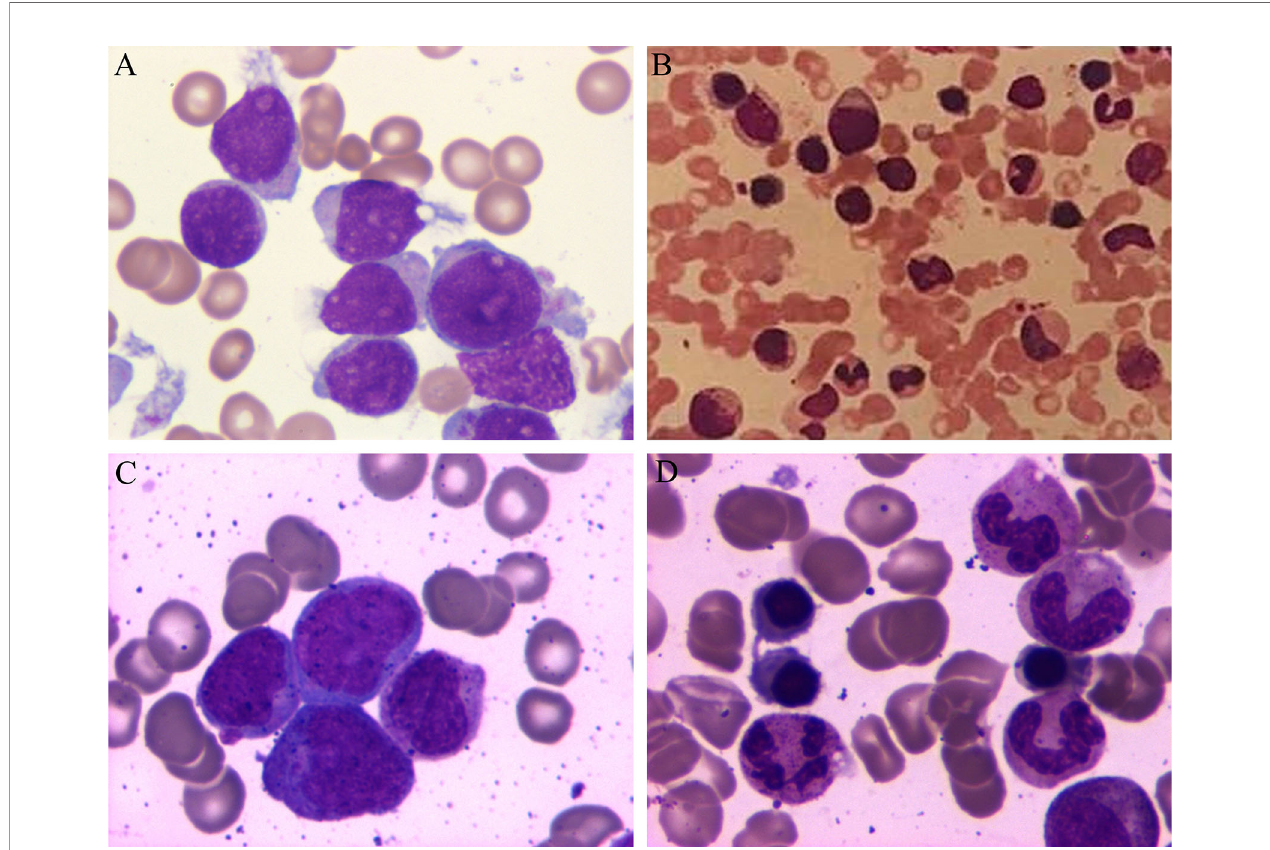
FIGURE 1 | Periodic acid-Schiff staining of bone marrow aspirate from the 3 patients at the time of admission. (A) Patient 1 had acute myeloid leukemia, (B) Patient 2 had chronic myeloid leukemia, and (C) Patient 3 had acute myeloid leukemia. (D) Patient 3 experienced complete remission after the